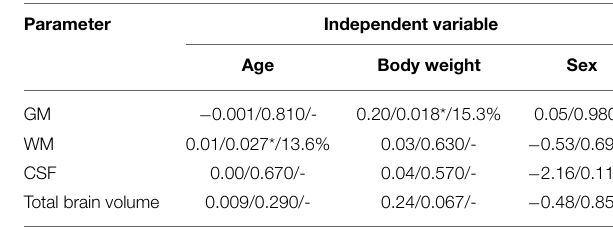
TABLE 5 | Tissue volumes analysis for a relation with body weight, age, and sexual dimorphisms (effect size/ p -value/partial explained